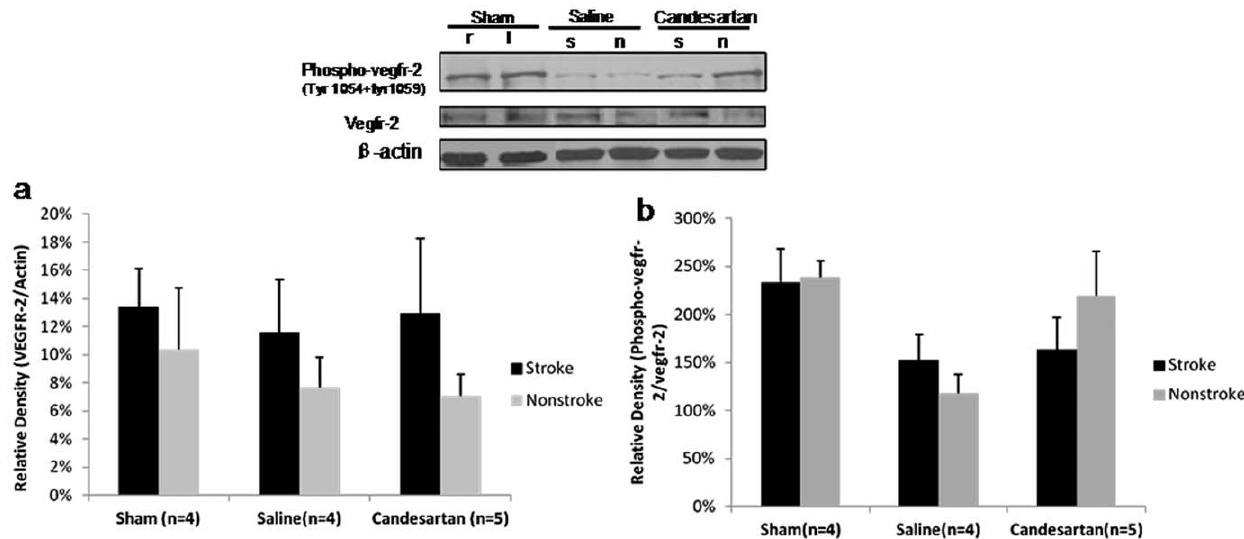
Figure 7. VEGF-2 expression in the brain. Candesartan treatment did not result in any changes in VEGFR2 protein expression (Figure 7a) or VEGFR-2(flk-1) activation (Figure 7b), as determined by the phosphorylation status, compared with saline-treated or sham animals in both